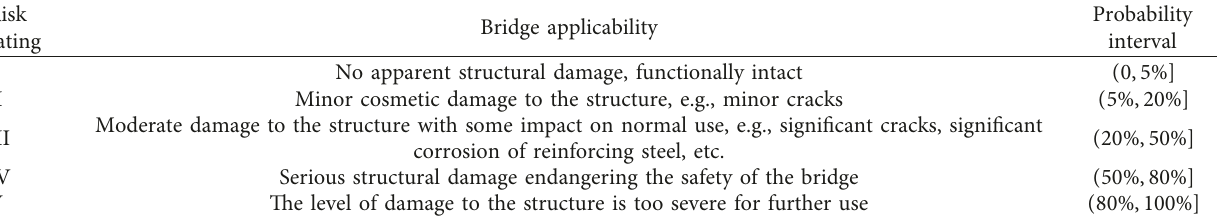
Table 3: Applicability status classes of existing railway bridges.